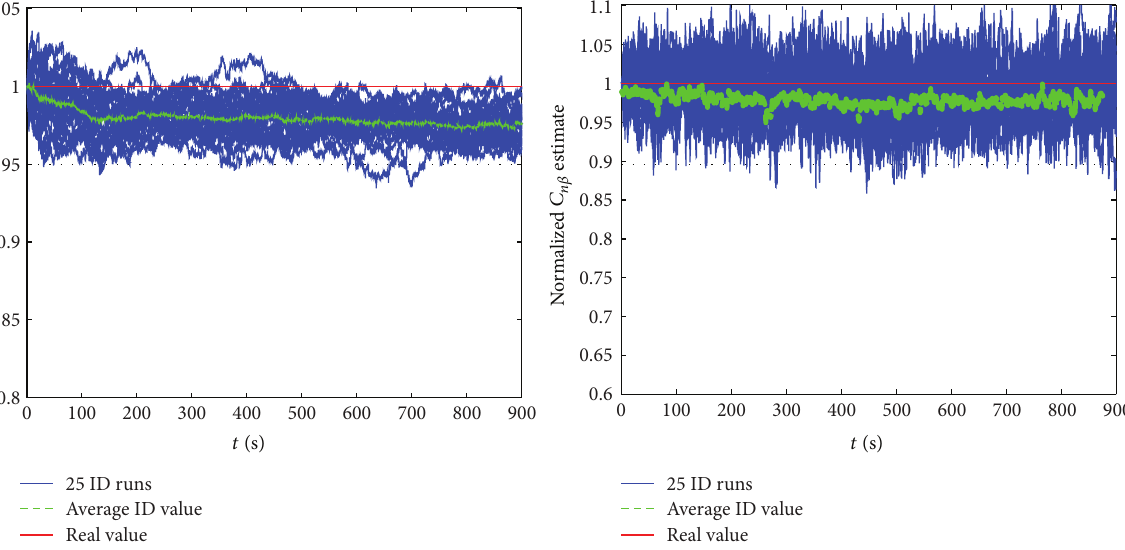
Figure 3: ID results for clean aircraft.